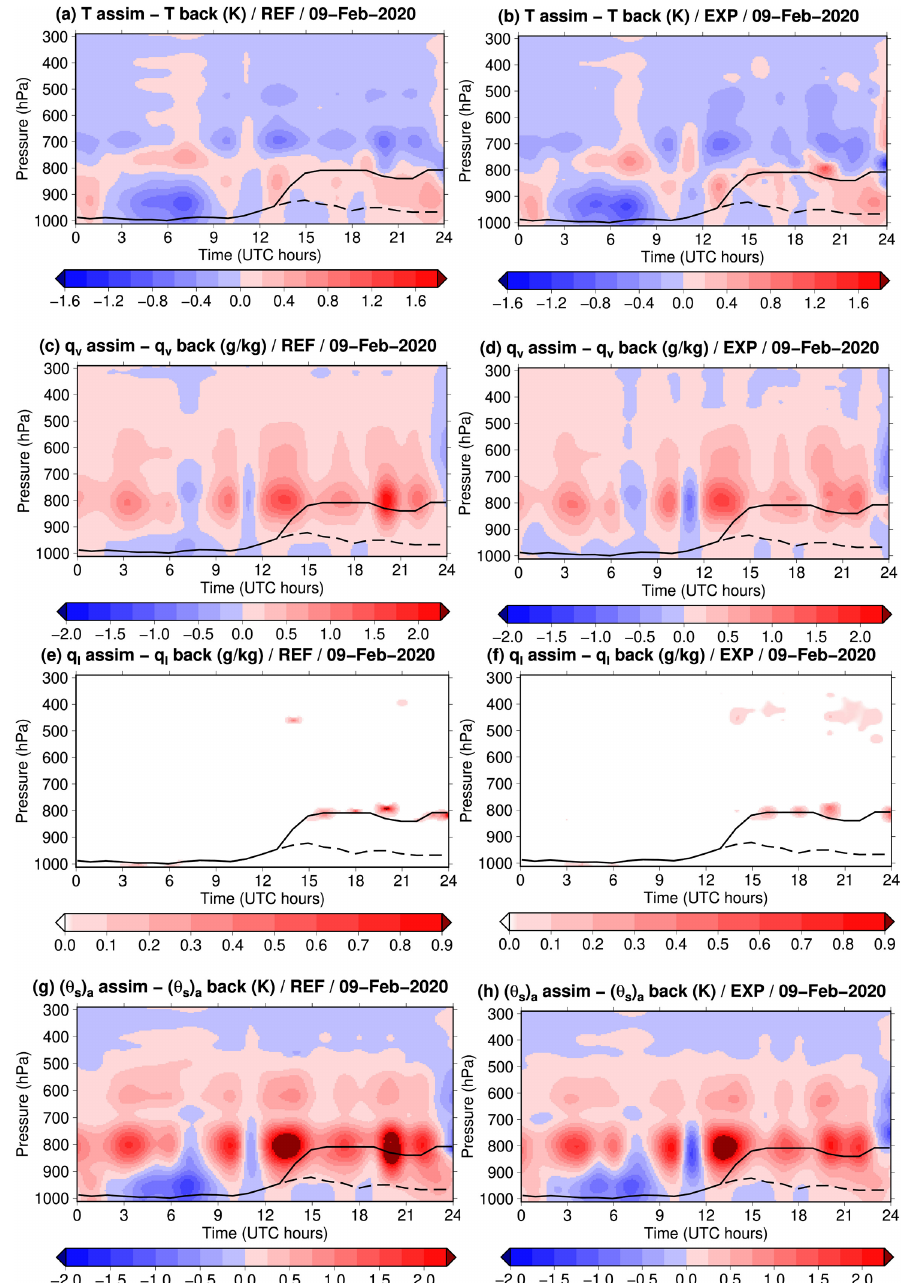
Figure 6. Profiles of analysis increments resulting from two 1D-Var experiments: REF (left) and EXP (right) for (a–b) T in K, (c–d) q v in gkg − 1 , (e–f) q l in gkg − 1 and (g–h) (θ s ) a in K. Colour bars have the same units (K or gkg − 1 ) as the